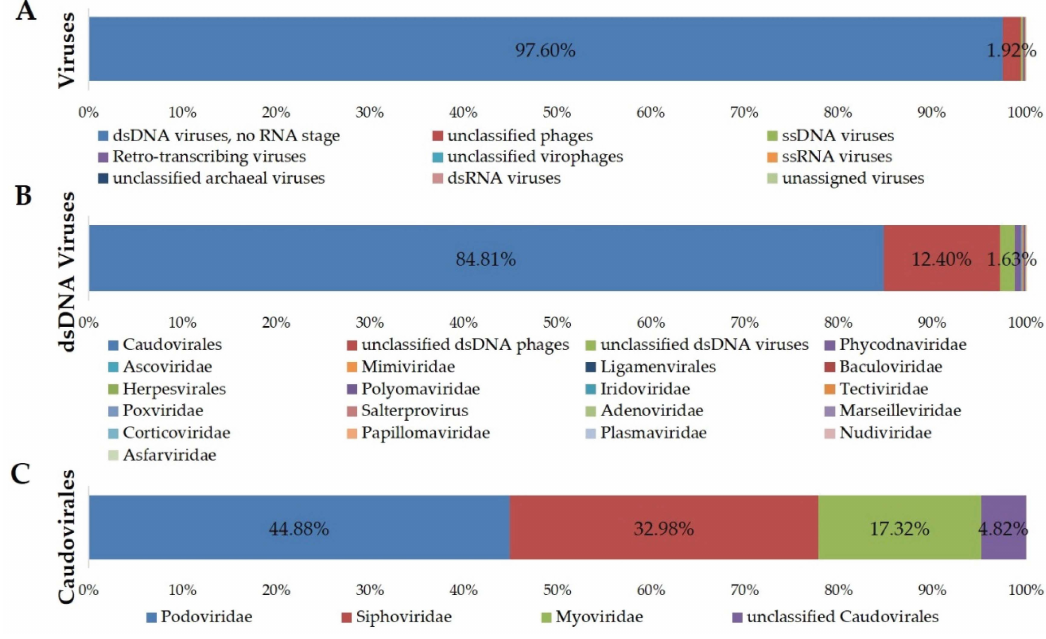
Figure 3. Taxonomic composition of the JRE virome, based on BLAST comparison with the NCBI Refseq complete viral genomes protein sequences database (release of 5 January 2015) by Metavir with an E -value threshold of 10 ´ 5